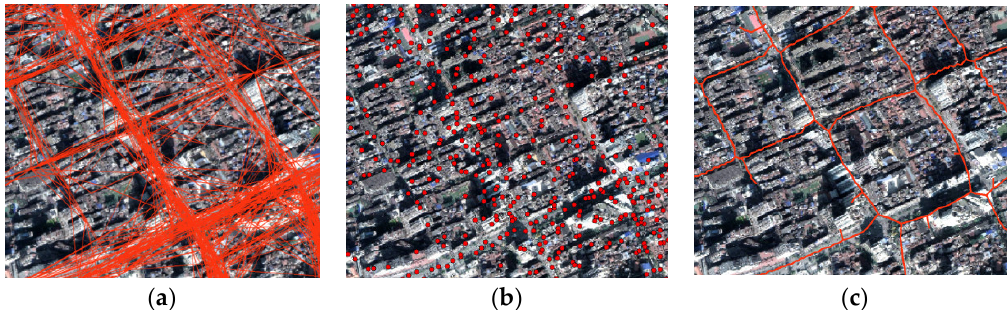
Figure 2. Extraction results of existing methods for old downtown areas. ( a ) The method of Cao; ( b ) the method of Edel- kamp; ( c ) the method of Davies.